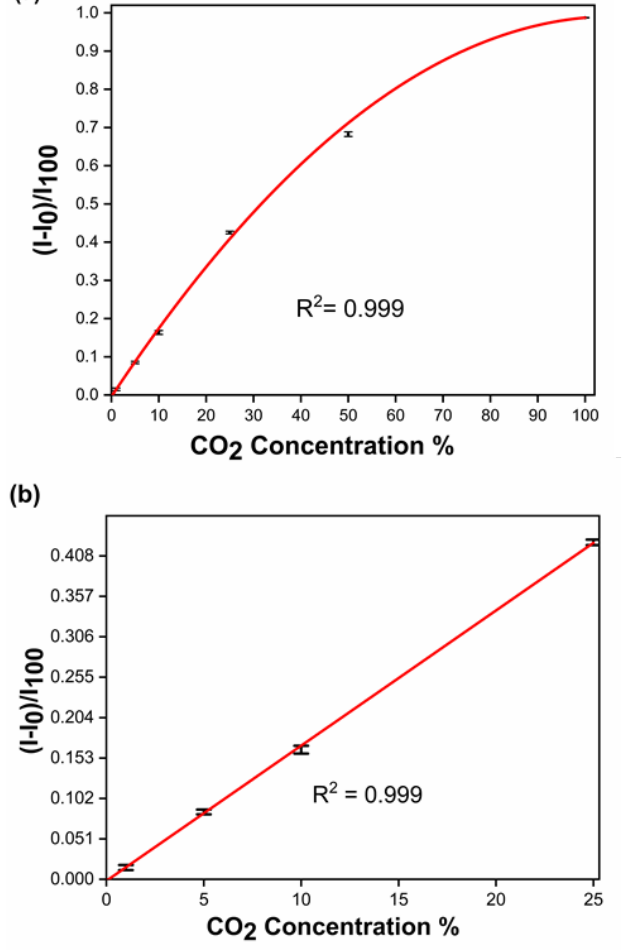
Figure 6. Variation of (I − I 0 )/I 100 with CO 2 concentration in N 2 of ( a ) 0–100% (entire range, polynomial fit) and ( b ) 0 – 25% (linear range).